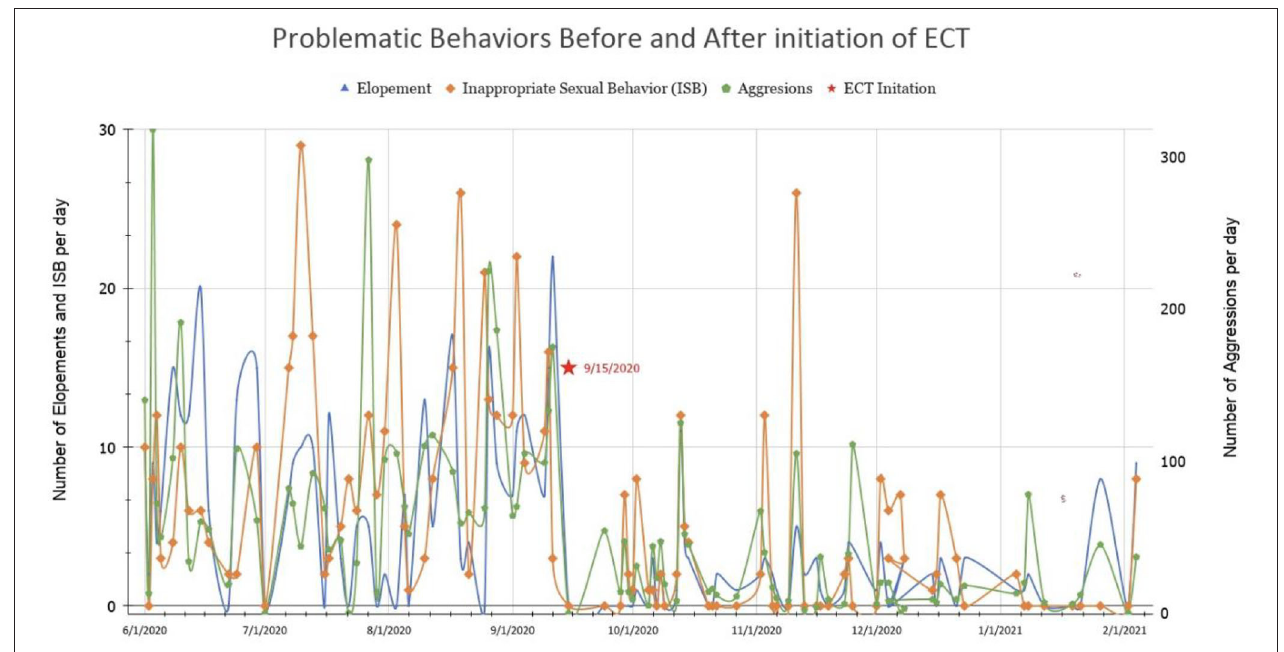
FIGURE 2 | Summary of behavior improvement following ECT initiation for Mr.